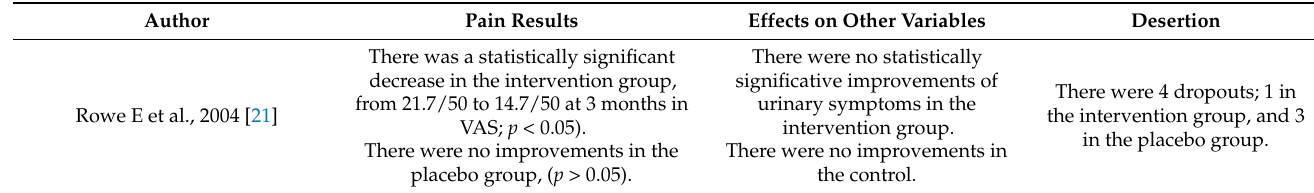
Table 5. Key findings of primary